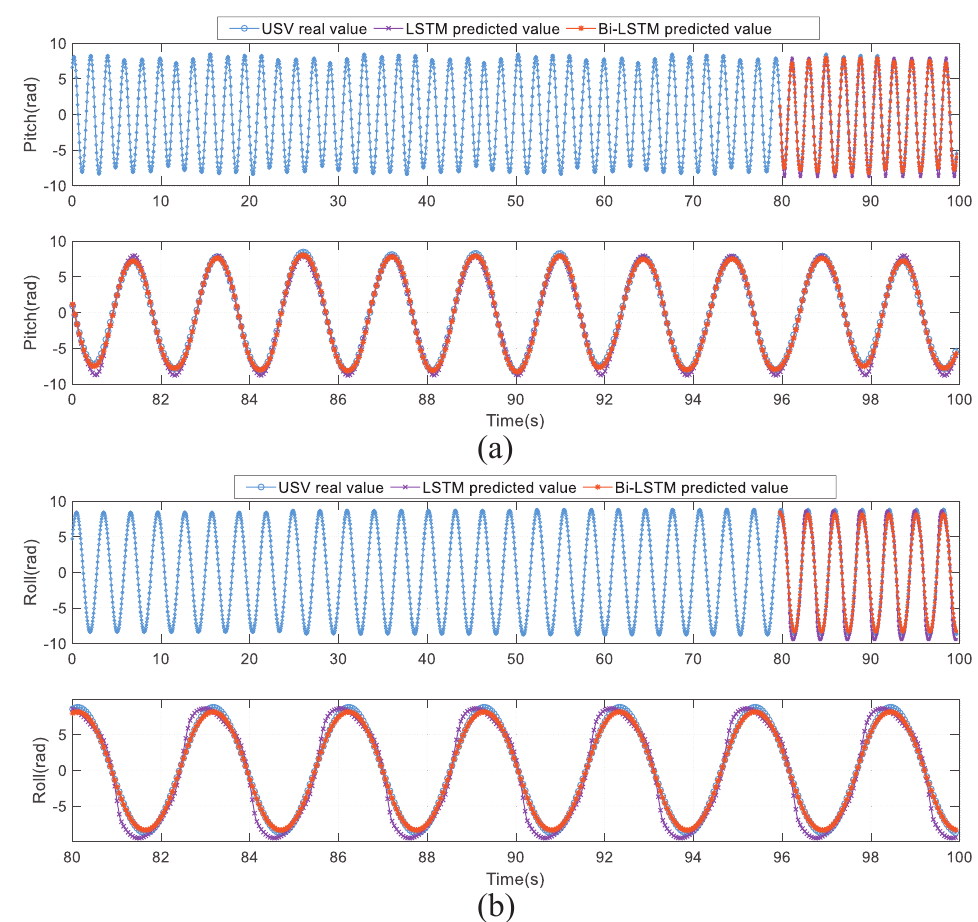
Figure 5. ( a ) pitch angle prediction results of USV; ( b ) roll angle prediction results of USV. The ratio of the training set to the test set is 8:2, i.e., the first 80 s are the training data and the second 20 s are test data.